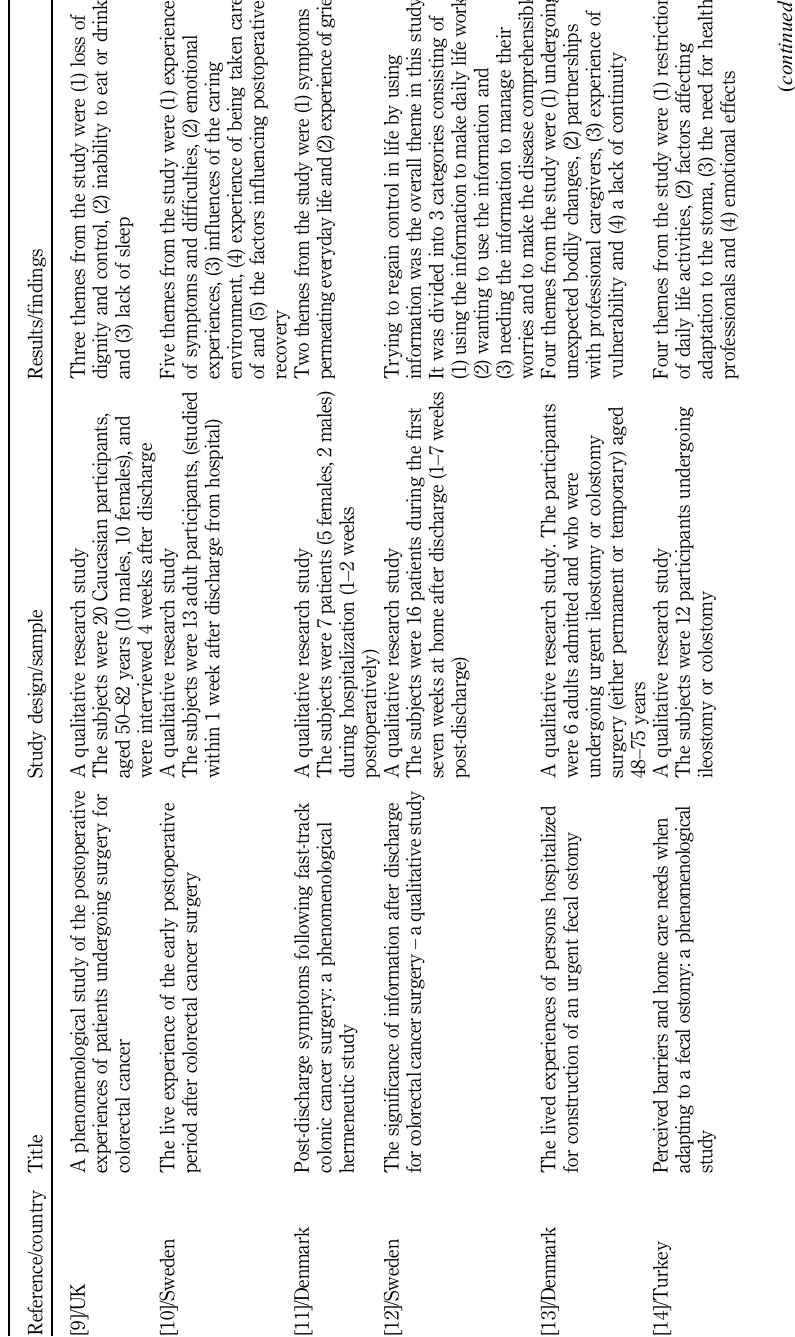
Table I. Summary of studies and their findings of the experiences of colorectal cancer patients during postoperative